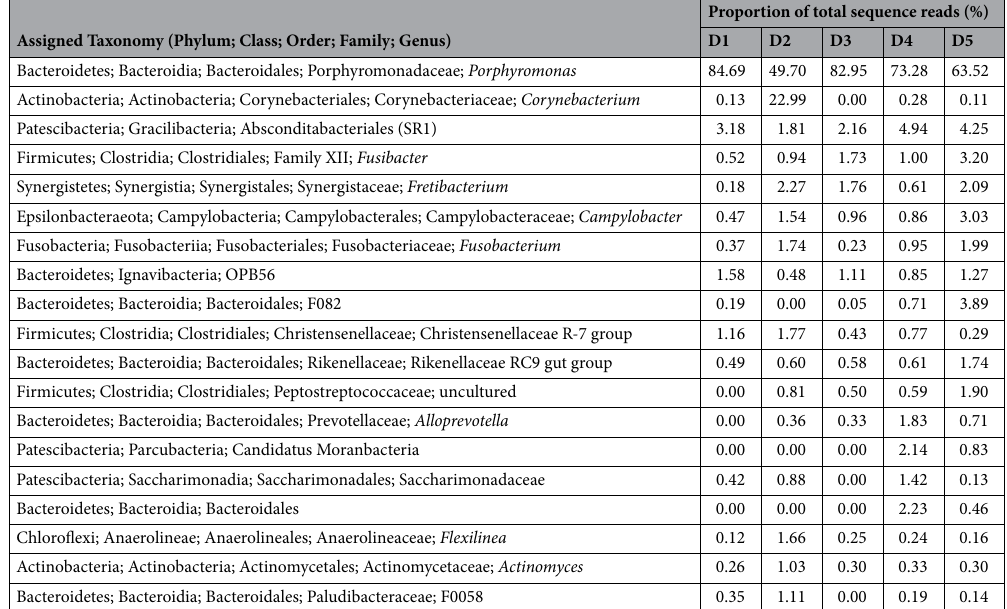
Table 2. The most abundant operational taxonomic units detected in canine dental biofilms. Designation D1 to D5 indicate individual dogs. The percent abundance refers to the proportion of 19 OTUs that represent at > 1% of total sequence reads present in at least one